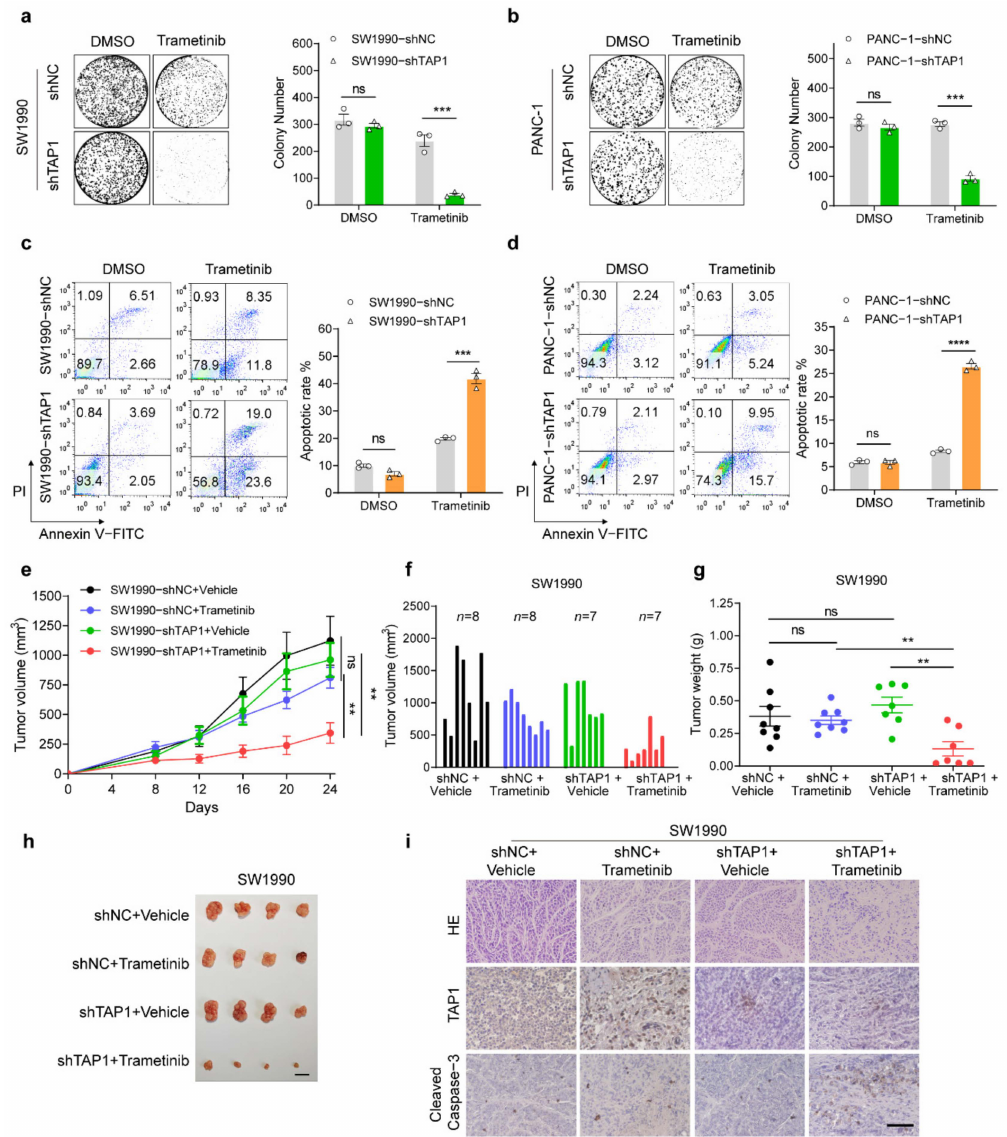
Figure 3. Suppression of TAP1 sensitizes the MEKi-resistant PDAC cells in vitro and in vivo. ( a , b ) Representative wells of the clonogenic growth assay upon knockdown of TAP1 or NC in SW1990 and PANC-1 cells after trametinib (100 nM) treatment for 12 days. Quantification of colony number is shown at the right. ( c , d ) Apoptosis rates of SW1990 and PANC-1 cells with shTAP1 or shNC were detected by Annexin V-FITC/PI detection kit after DMSO or trametinib (40 µ M) treat- ment for 72 h. The quantitative results are shown at the right. ( e ) Tumor volume measurements at the indicated time points for SW1990-shNC and SW1990-shTAP1 tumors, treated with trametinib (1 mg/kg) or vehicle control by via oral gavage daily. ( f , g ) Tumor volume and tumor mass at the endpoint of experiments. ( h ) Images of four representative primary subcutaneous tumors for each of the indicated treatment groups. Scale bar, 1 cm. ( i ) Hematoxylin and eosin (H and E) staining and IHC staining of TAP1 or cleaved caspase-3 in primary tumor tissues. Scale bars, 200 µ m.